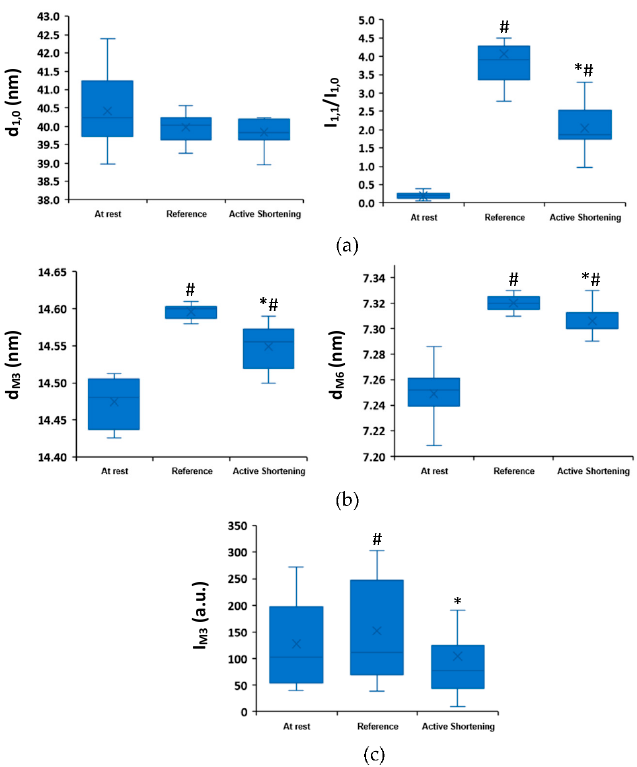
Figure 4. The equatorial and meridional reflections, at an average SL of 2.6 µm, at rest (Rest), and at steady-state isometric contraction following a purely isometric reference contraction (Reference) and an active shortening contraction (Active Shortening). ( a ) Lattice spacing (d 1,0 ) and the intensity ratio (I 1,1 /I 1,0 ) measured from the equatorial reflections; ( b ) M3 and M6 spacings (d M3 and d M6 ) measured from the meridional reflections; ( c ) M3 intensity (I M3 ) measured from the meridional reflections. *: indicates a significant difference from the reference condition, #: indicates a significant difference from the rest condition. Data ( n = 10 bundles) are shown as box plots, where whiskers show minimum and maximum values, boxes indicate the interquartile range from Q1 to Q3, and the median values are shown (x).